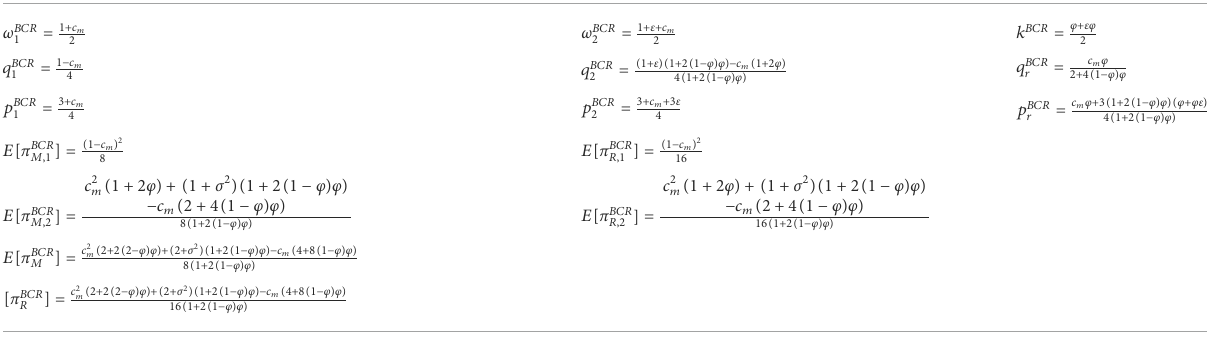
TABLE 4 The equilibrium outcomes of BCR